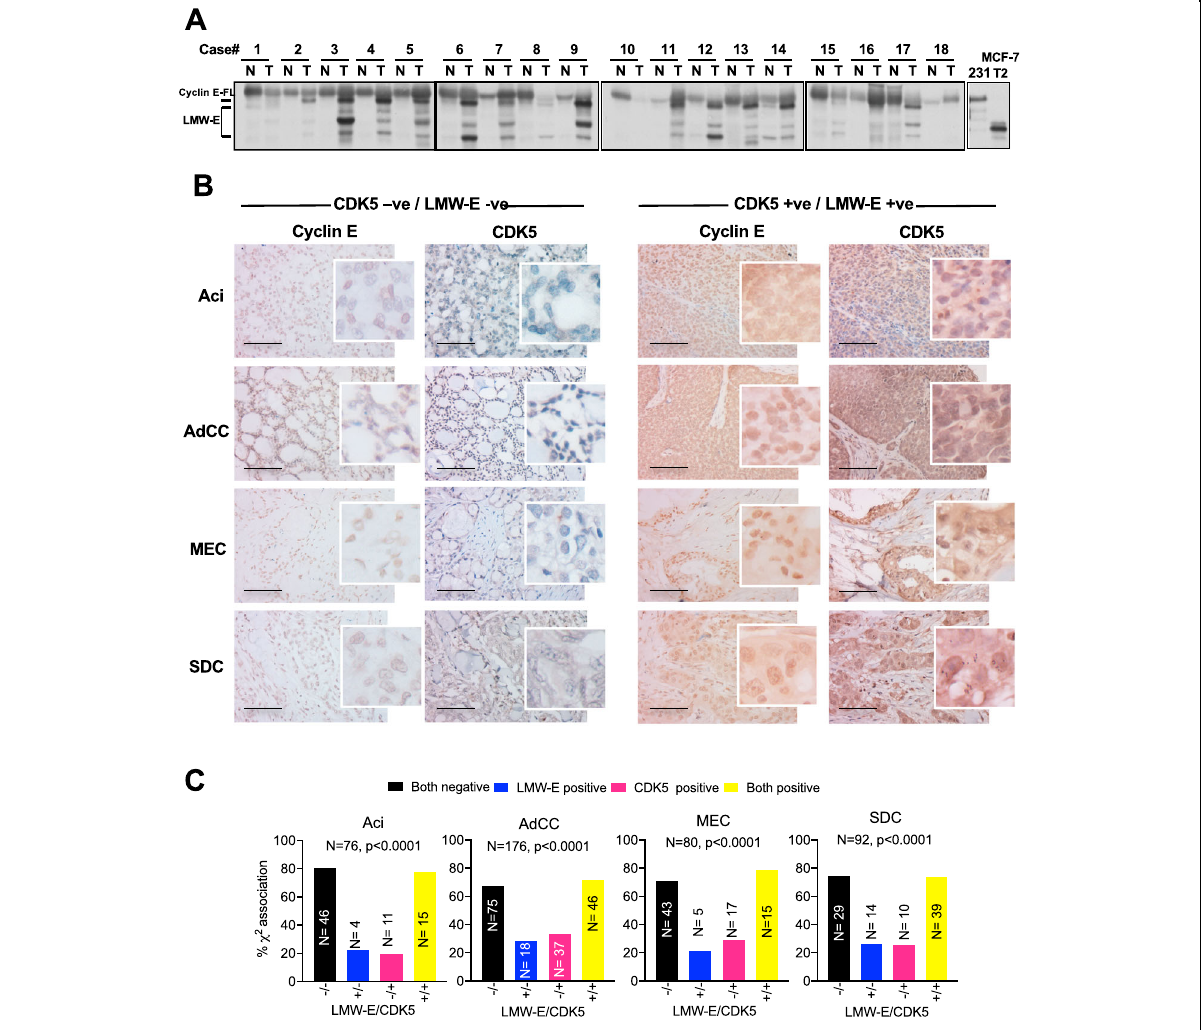
Fig. 4 LMW-E and CDK5 are co-expressed in human salivary gland tumors. A Western blot analysis of cyclin E, in 18 salivary gland tumor samples from patients of different histological subtypes. Lane designations correspond to sample numbers given in Supplementary Table 1 .231: MDA-MB-231 parental cells; MCF-T2: MCF-7 cells transfected with LMW-E (T2 isoform) B Analysis of cyclin E and CDK5 expression in different histologic subtypes of salivary duct carcinomas. Representative immunohistochemistry images for CDK5 and cyclin E are shown. Original magni fi cation: ×200 (main images); ×800 (insets). Speci fi cally, cyclin E (A1 – D1) and corresponding CDK5 (A2 – D2) staining for low cyclin E/CDK5; cyclin E (A3 – D3) and corresponding CDK5 (A4 – D4), for high CDK5/cyclin E expression. C Correlation analysis between high/low cyclin E (cytoplasmic staining) and CDK5 expression in salivary gland tumors samples of patients from four different subtypes. Black bar = both negative/ low expression of LMW-E and CDK5, blue bar = one positive/high LMW-E expression only, pink bar = one positive/high CDK5 expression only and yellow bar = both positive/high expression of both LMW-E and CDK5. p Values indicate a signi fi cant correlation between cyclin E (cytoplasmic staining) and CDK5 expression and were calculated by the Chi-square ( χ 2 ) test of